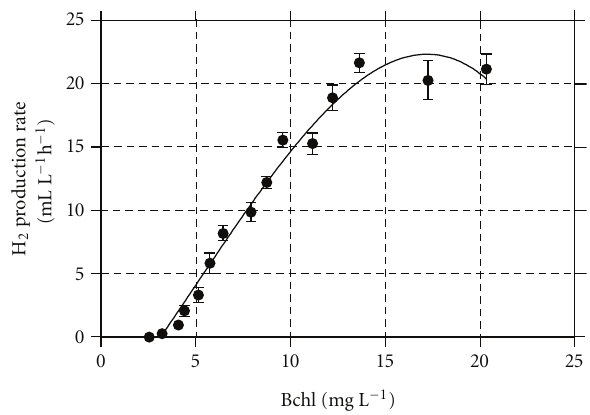
Figure 3: Hydrogen production rate versus the Bchl concentration attained under batch growth conditions, at 30 ◦ C with an irradiance of 480 Wm − 2 .